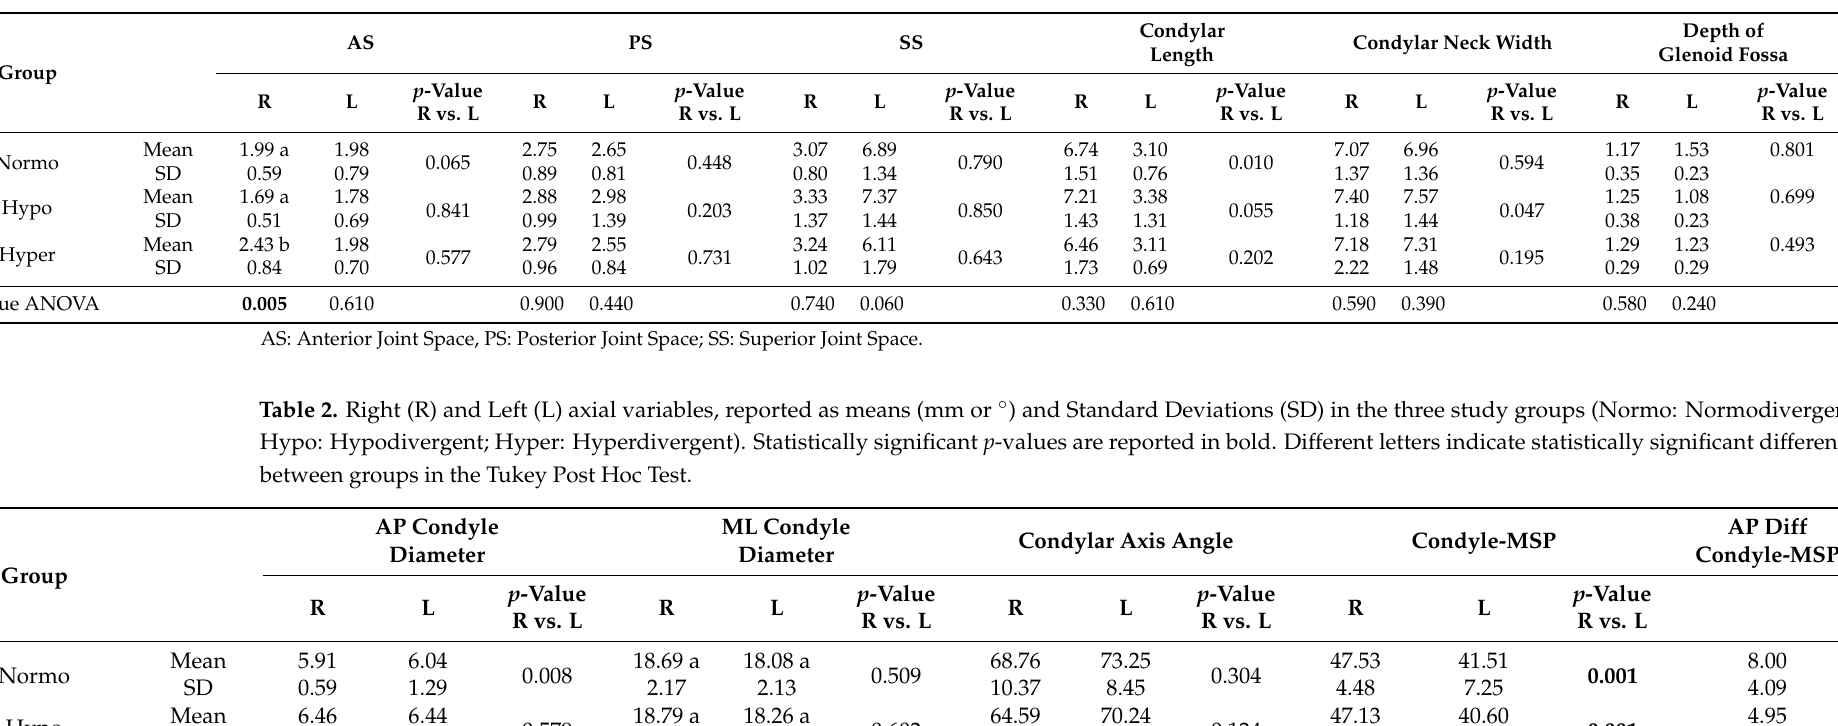
Table 1. Right (R) and Left (L) sagittal variables, reported as means (mm) and Standard Deviations (SD) in the three study groups (Normo: Normodivergent; Hypo: Hypodivergent; Hyper: Hyperdivergent). Statistically significant p -values are reported in bold. Different letters indicate statistically significant difference between groups in the Tukey Post Hoc Test.